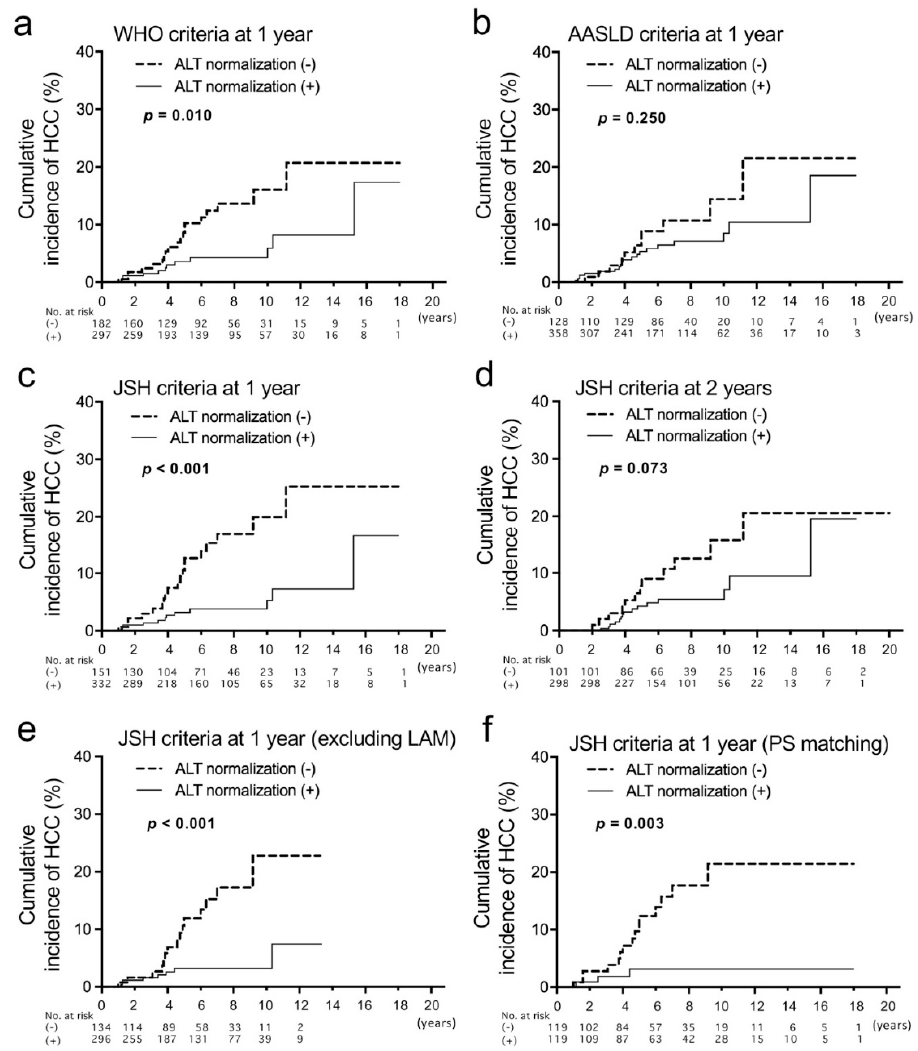
Figure 2. Analyses of cumulative incidences of HCC according to the achievement of alanine aminotransferase (ALT) normalization 1 year after the start of nucleos(t)ide analog therapies that were evaluated with three types of criteria. ( a – c ) Comparison of cumulative incidences of HCC between patients who achieved ALT normalization based on the criteria of the World Health Organization (WHO: male, ≤ 30; female, ≤ 19) ( a ), American Association for the Study of Liver Diseases (AASLD: male, ≤ 35; female, ≤ 25) ( b ) and the Japan Society of Hepatology (JSH: ≤ 30) ( c ). In these analyses, patients who developed HCC before 12 months and those whose observation periods were less than 12 months were excluded. ( d ) Comparison of cumulative incidences of HCC based on the ALT normalization criteria of JSH at 2 years of therapy. ( e ) Comparison of cumulative incidences of HCC based on the ALT normalization criteria of JSH at 1 year, excluding patients who were treated with lamivudine (LAM). ( f ) Comparison of cumulative incidences of HCC between patients with and without ALT normalization at 1 year based on JSH criteria after propensity score (PS) matching.